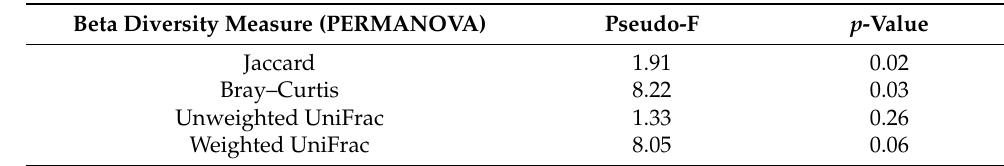
Table 1. PERMANOVA analysis based on distance matrices between laboratory-reared T. stercorea larvae and